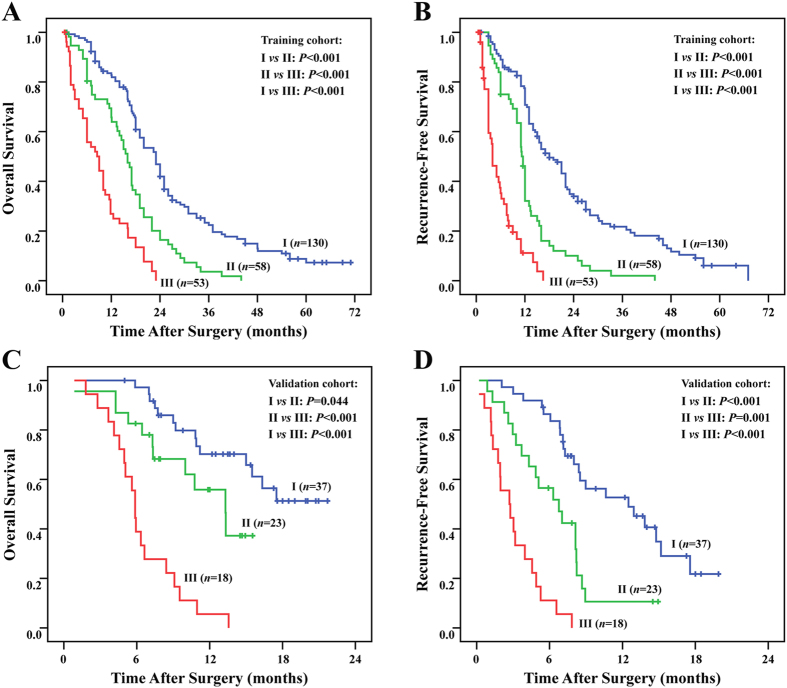
Cumulative (A) overall and (B) recurrence-free survival curves of the combination of intratumoral mutant p53 and cavin-1 expression, and (C, D) their validation. Patients with the combination of mutant p53 status and strong cavin-1 expression (group III) had the shortest survival after resection of PDAC.